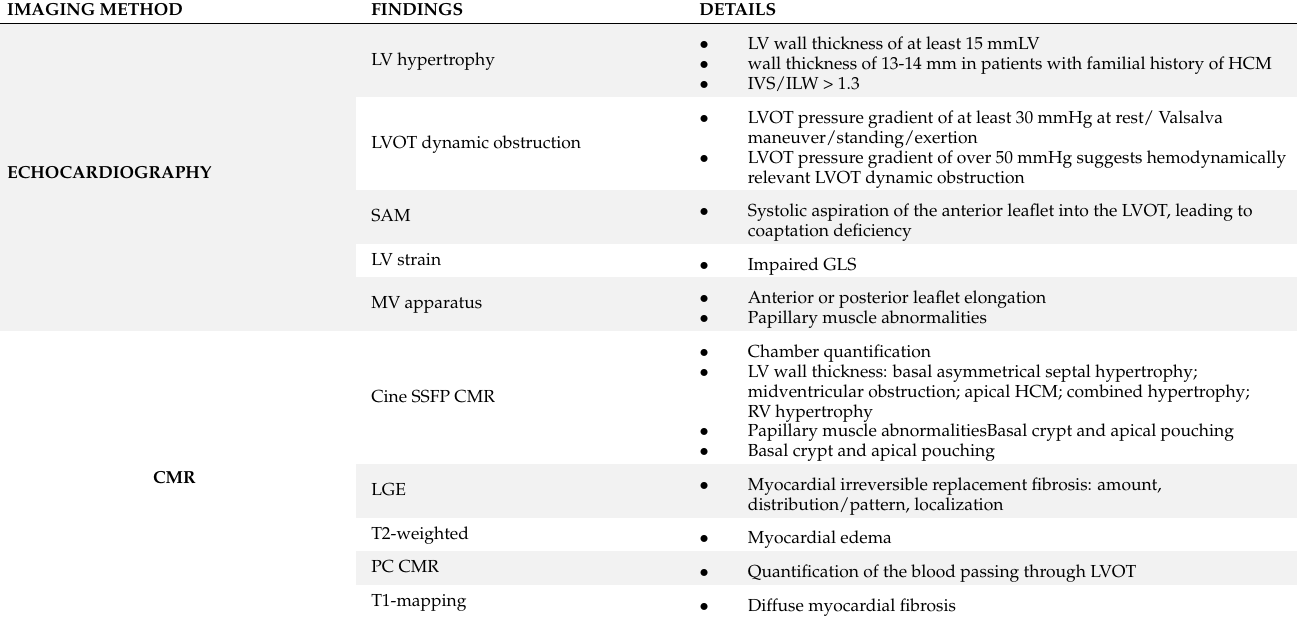
Table 1. Multimodal imaging findings in patients with hypertrophic cardiomyopathy.